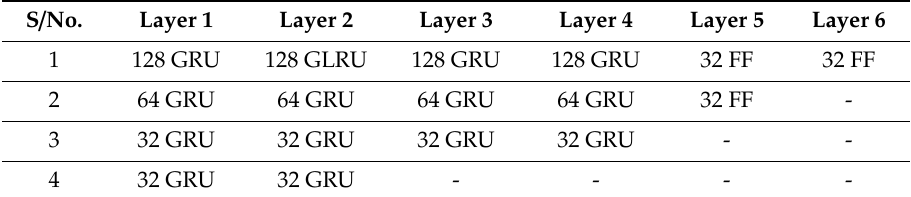
Figure 10. Comparison of LOCF forecasting, SVR forecasting, and measured data. Table 4. Base models (FF = feedforward). Table 4. Base models (FF = feedforward).